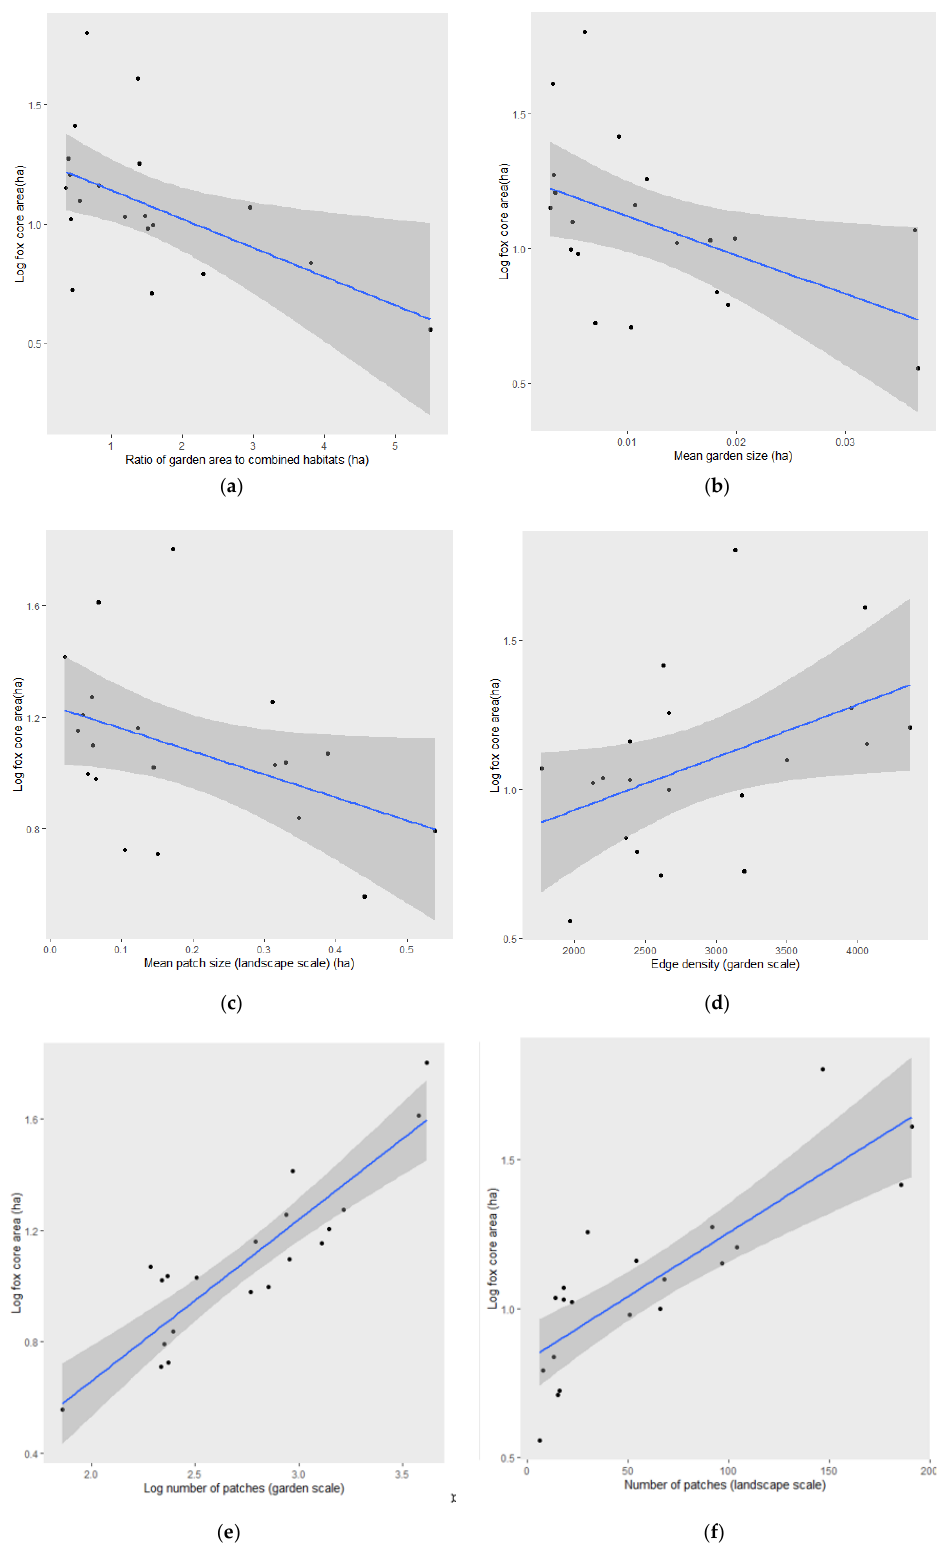
Figure 2. Predict plots for log-transformed core area size (ha) against: ( a ) absolute garden area (ha) as a ratio relative to all other habitats (H1); ( b ) mean garden size (ha), ( c ) mean patch size (landscape scale) (ha); ( d ) ED (garden scale) (H2); ( e ) number of gardens; ( f ) number of patches (landscape scale) (H3). Regression lines are shown in blue, confidence intervals in grey. Table 3. Model fits for significant bivariate linear mixed models (lmm) explaining core area size in urban foxes. These were also run as generalized linear mixed models (glmm) to generate ∆ deviance (change in deviance attributed to the explanatory variable as a percentage of total deviance (residual + null)). * Akaike Information Criterion; ** percentage of the total variance explained by the random factor fox ID (i.e., residual variance/total variance).